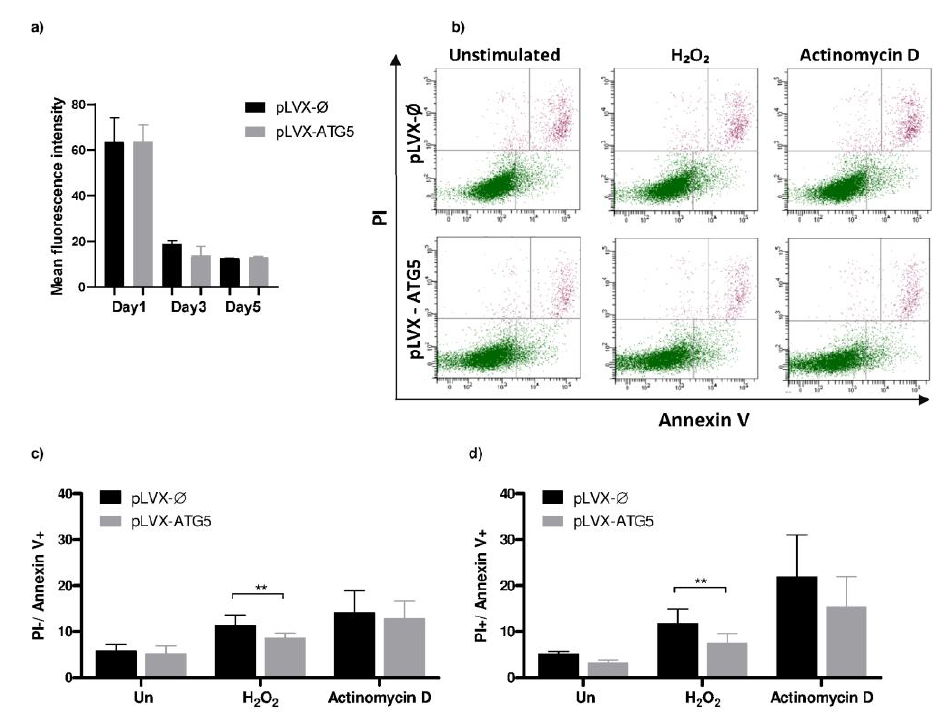
Figure 5. HL-60-ATG5 cells do not reveal altered proliferative potential but are more resistant to chemically induced apoptosis. ( a ) Mock control and HL-60-ATG5 cells were stained with 1 µM VPD450 dye and incubated for 5 days. Proliferation rate was assessed by flow cytometry analysis of median fluorescence intensity (MFI) on the first, third and the fifth day of the experiment. The data are representative of one out of five independent experiments. ( b – d ) Mock control and HL-60-ATG5 cells were incubated in the presence of 10 µM H 2 O 2 or 1 µg/mL actinomycin D for 16 h, stained using fluorescein isothiocyanate (FITC)-conjugated annexin V and propidium iodide (PI) and analyzed by flow cytometry. ( b ) Representative dot plots. Percentage of early ( c ) and late ( d ) apoptotic cells. The data are presented as means + SEM of five independent experiments. ** p ≤ 0.01, two-way ANOVA with post-hoc Holm–Šídák’s test.